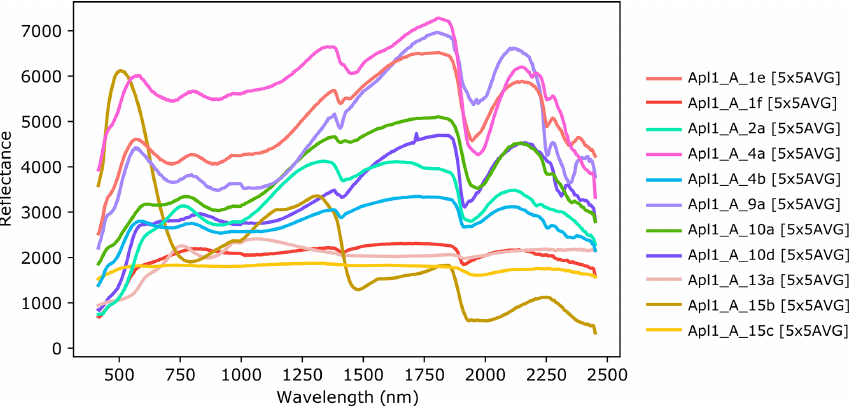
Figure 13. Detailed, unstacked view of a selection of spectra. Reflectance scaled from 0–10000, modified from Koerting (2021).